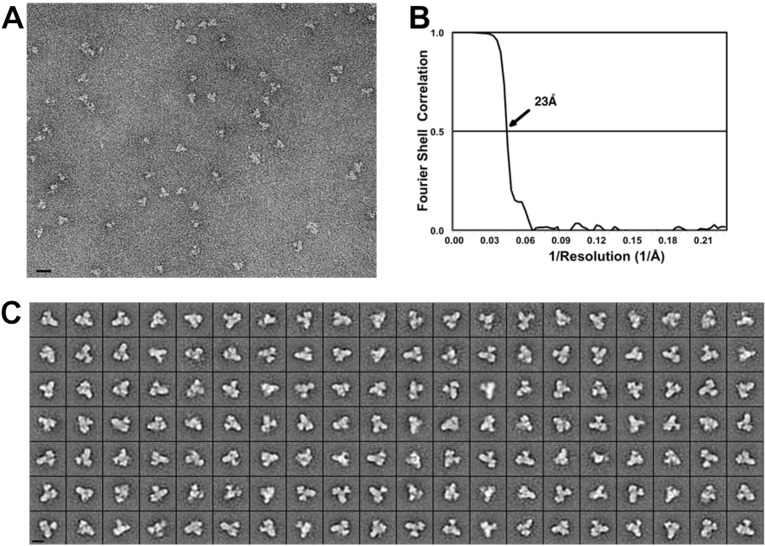
Negative stain EM of the core BBSome complex.(A) Typical digital micrograph area of negatively stained BBSome particles (scale bar, 20 nm). (B) Fourier shell correlation of the 3-D reconstruction (prior to masking) (C) Class averages of negatively stained BBSome particles, each containing 11–86 particles (scale bar, 10 nm).